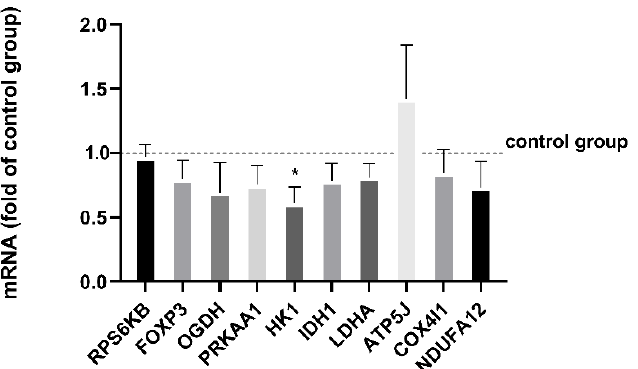
Figure 4. Normalized mRNA levels of CD4+ T cells from cohort 2 after 48 h in the exercise cell culture measured by real-time PCR are displayed as fold of the control group (=1.0). Human CD4+ T cells were activated in culture with 50% serum before exercise (control group) or after exercise. Both were activated with anti-CD3/anti-CD28. mRNA levels were normalized using the geometric mean of expression data of the reference genes SDHA, YWHAZ, and ATP5B. Data are shown with mean ± SEM (n = 5). Significance was determined by two-tailed Student’s t -test using the normalized mRNA data. * p < 0.05.